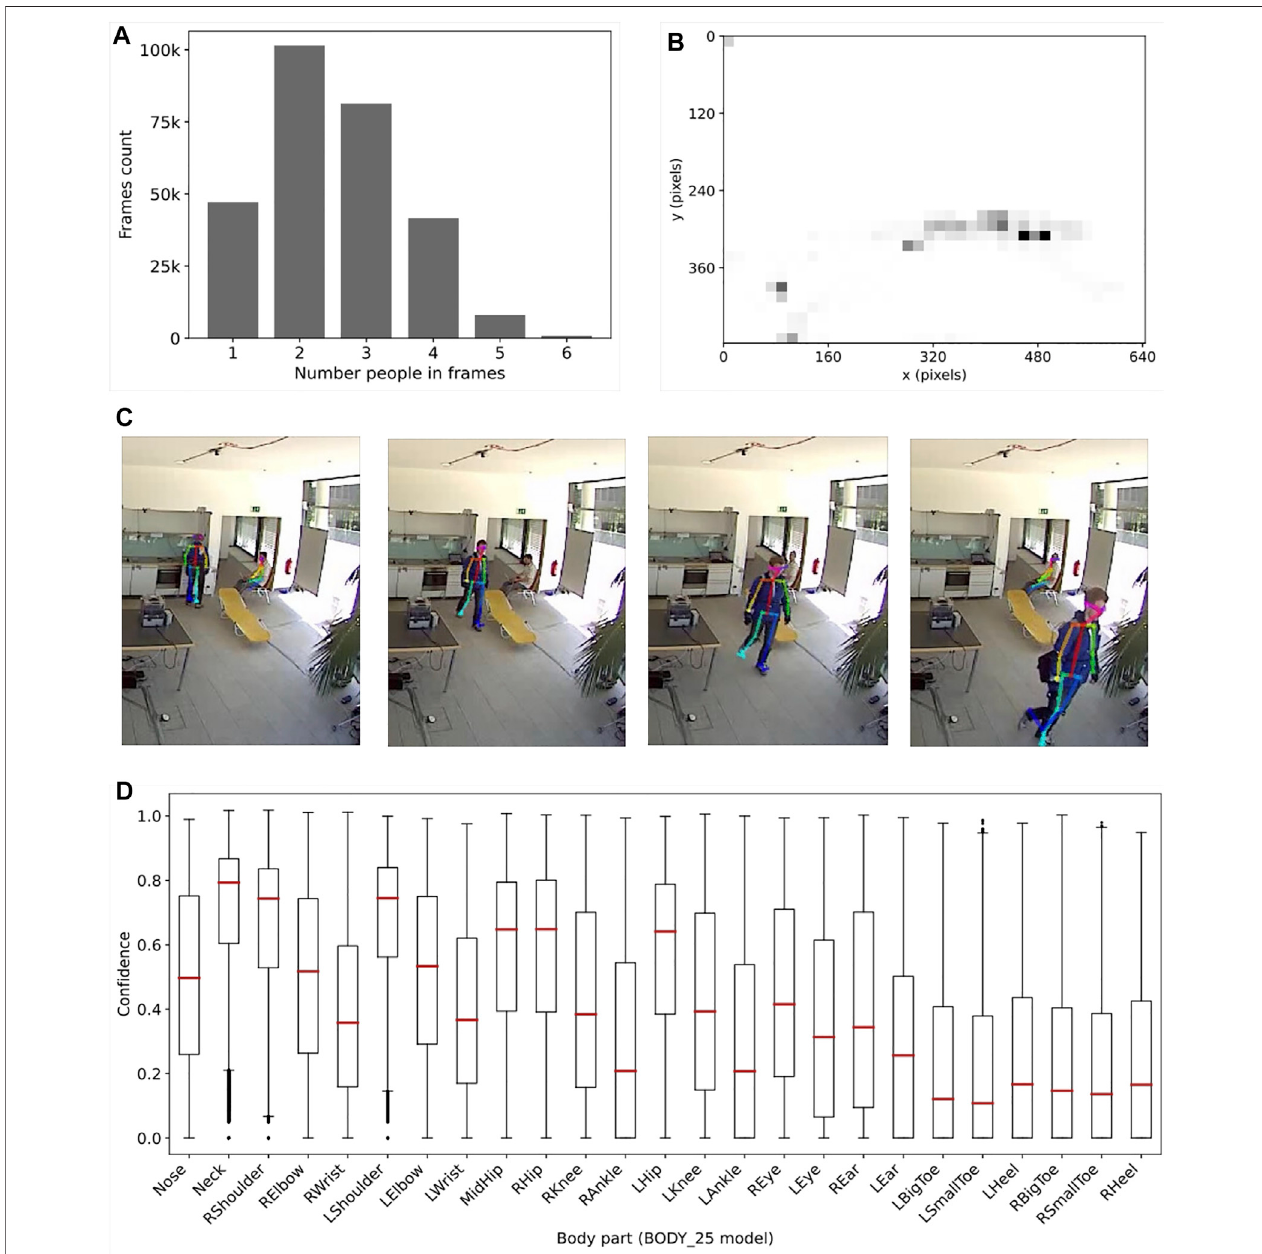
FIGURE2| OpenPosetrackinganalysis. (A) plotsthecountingofpeopleinalltheframesofallthevideos. (B) presentsthedistributionofthepeopleintheframesin all the videos, calculated using the Neck coordinates. (C) shows a four consecutive frames with the skeleton produced by the people tracking. Finally, (D) indicates the distribution of the con fi dence values for all the body parts of the BODY_25